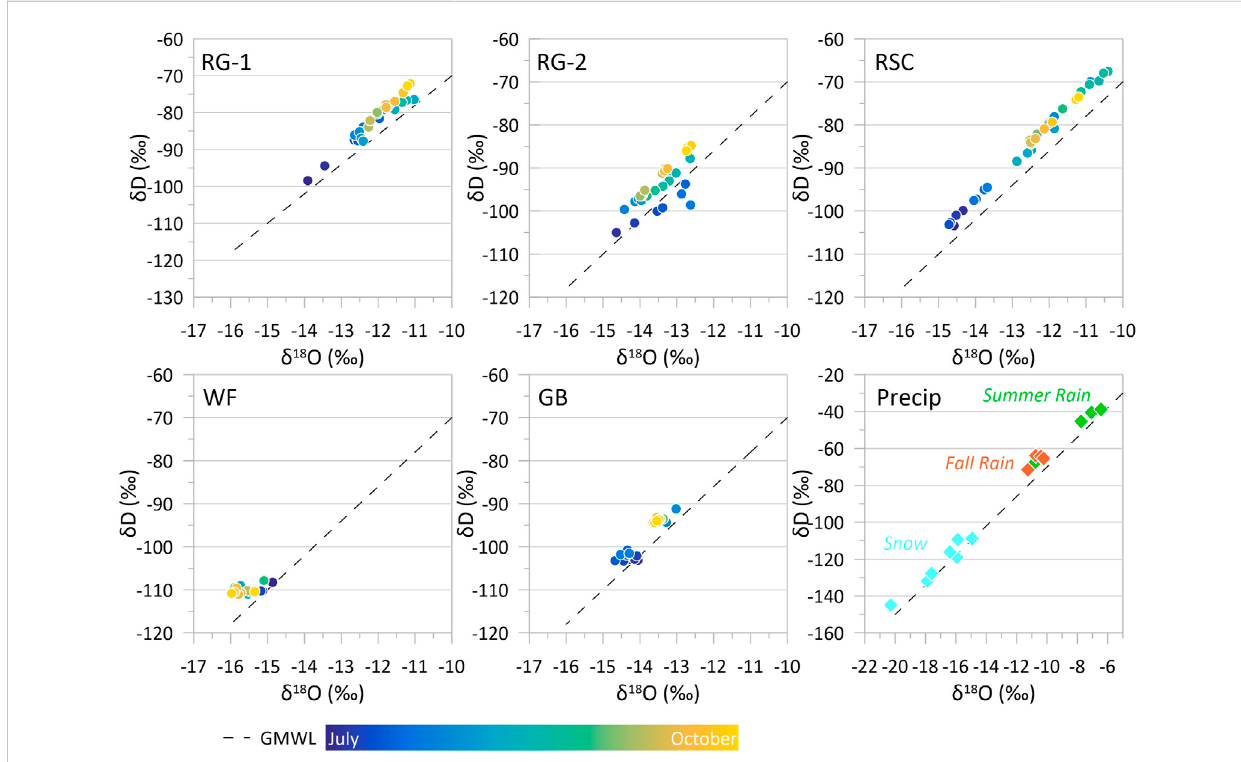
FIGURE 3 Plots of δ 18 O vs. δ D for RG-1 and RG-2 in the Uinta Mountains; RSC, GB, and WF in the La Sal Mountains; and precipitation collected at both sites. Dashed line marks the global meteoric water line for reference (Craig, 1961). Colored symbols for the fi ve water samplers correspond with the month of